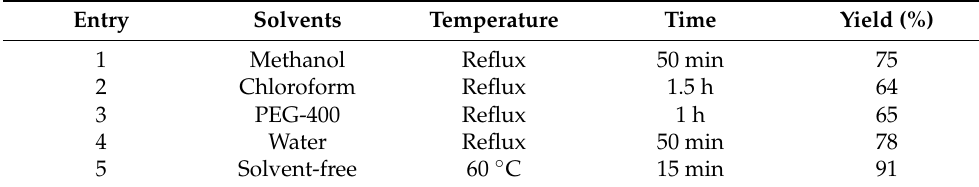
Table 2. Effect of solvents on model